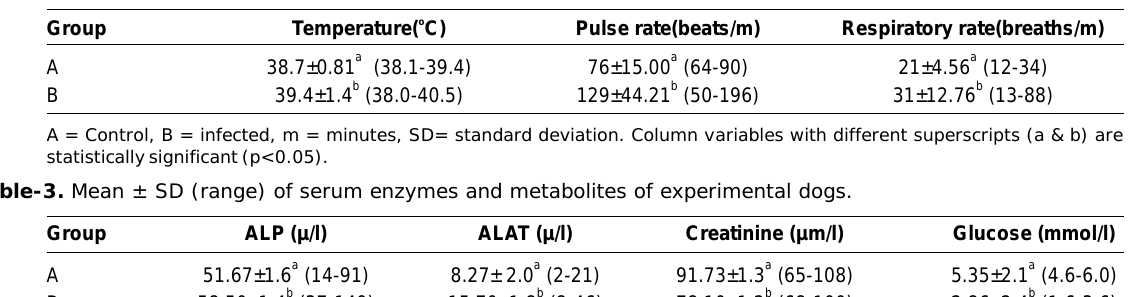
Table-2. Mean± SD (range) of vital parameters of experimental dogs.